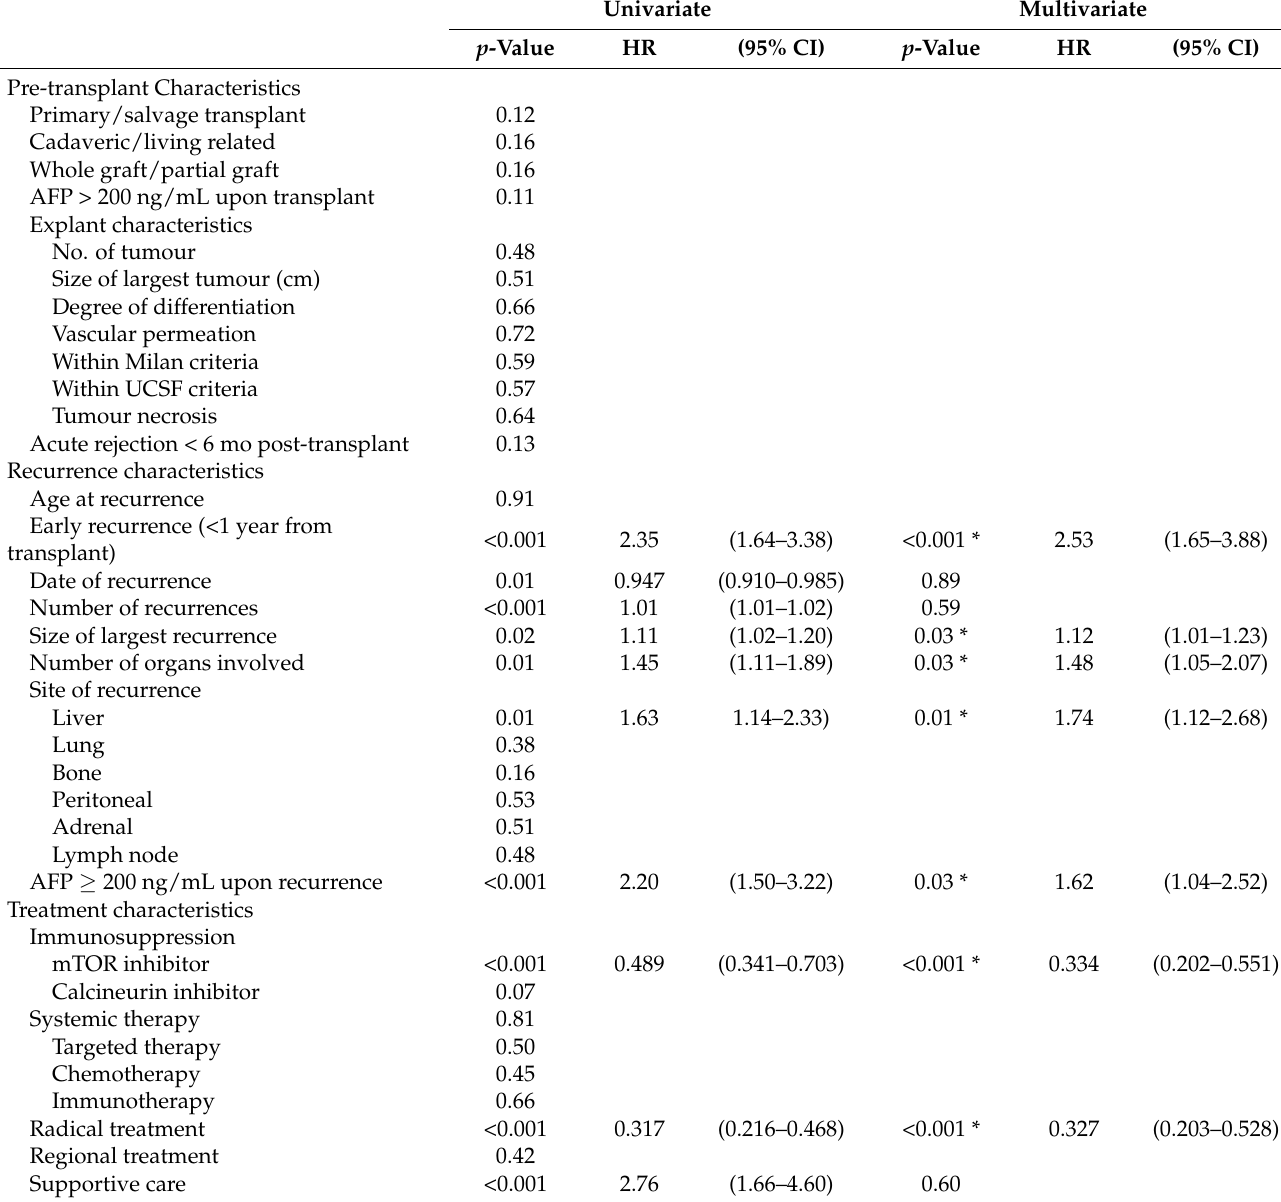
Table 2. Univariate and multivariate predictors of post-recurrence survival. Univariate